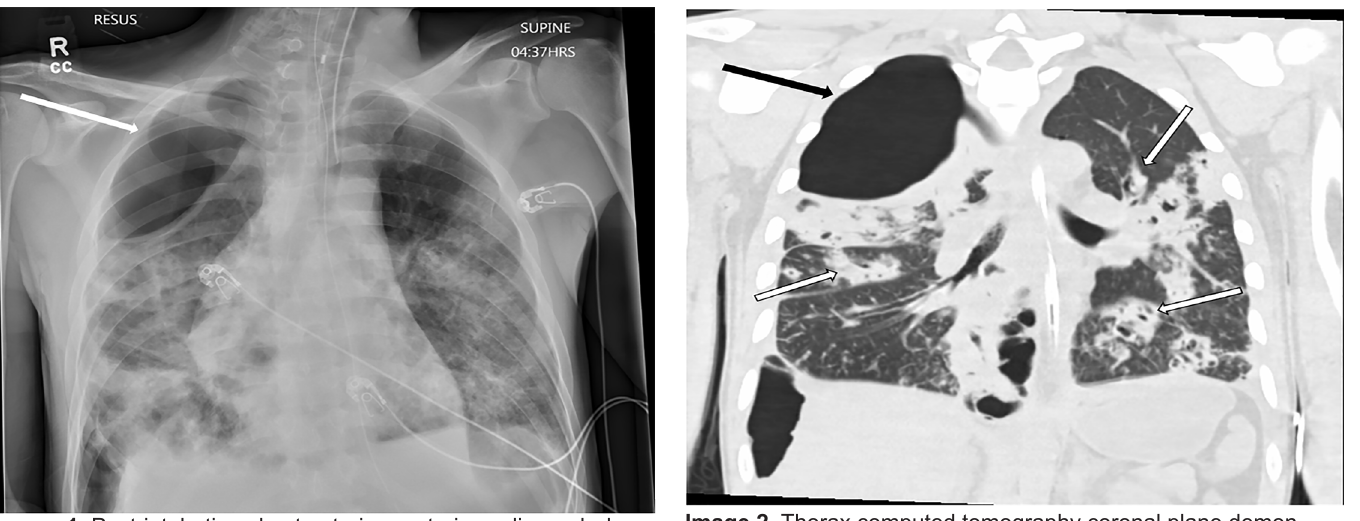
Image 1. Post-intubation chest anterior-posterior radiograph dem- onstrating pneumonia and gigantic bulla (white arrow).